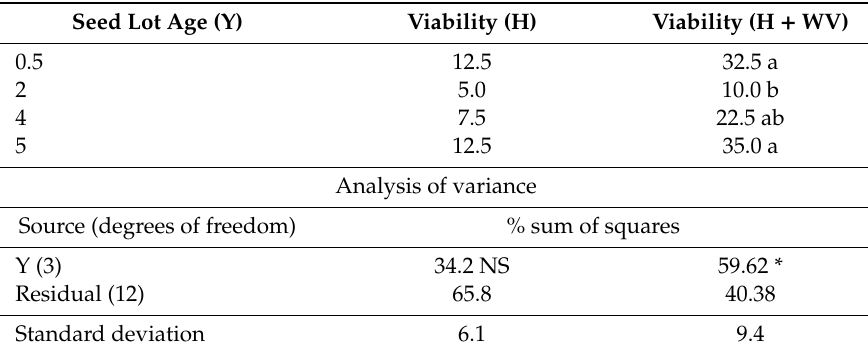
Table 1. E ff ects of the seed lot age (years) on the viability (%) of the seeds, considering only the healthy seeds (H) and considering both the healthy and viable but with weak tissues (H + weak, but viable (WV)). Mean values.